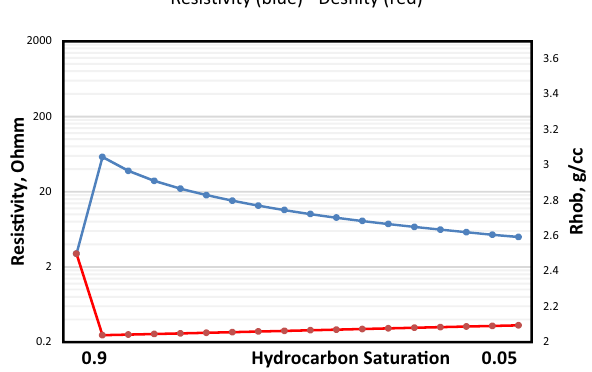
Fig. 12 Density–resistivity overlay, clay = 25%, m = 4